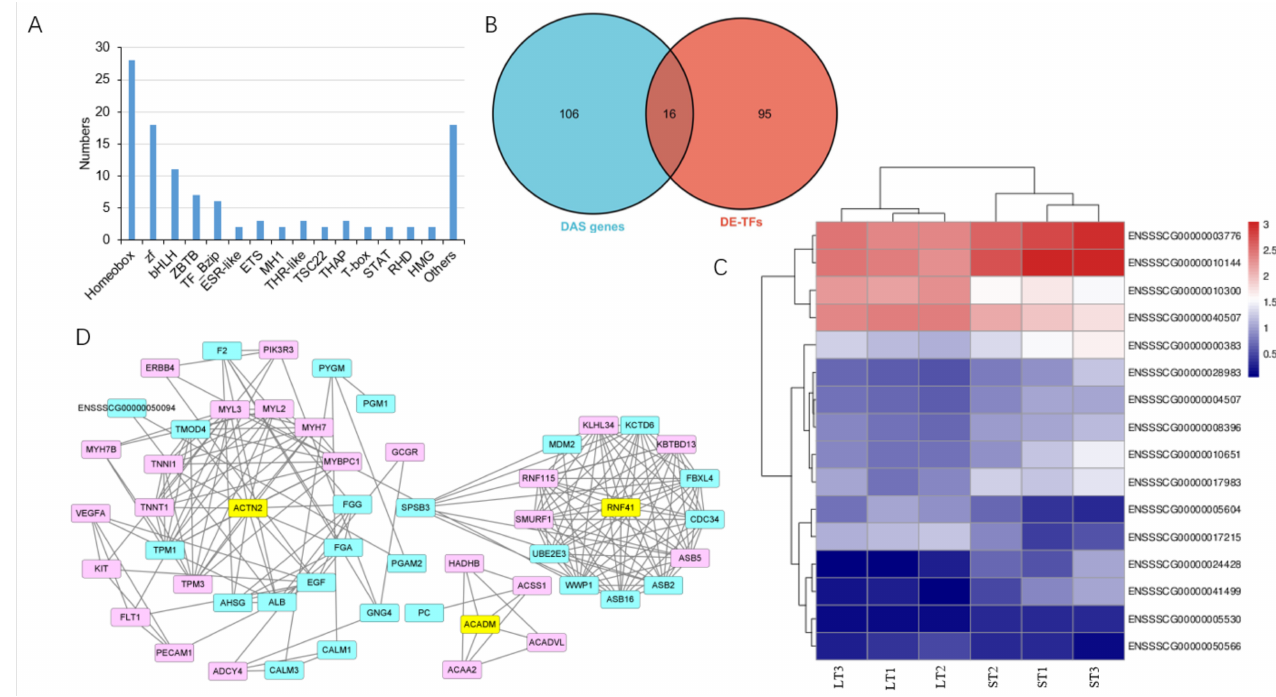
Figure 7. Characterization of differentially expressed transcription factors (DETFs) among differential alternative splicing (DAS) genes. ( A ) family analysis of DETFs; ( B ) Venn diagram of DETFs and DAS genes; ( C ) heatmap of DAS-DETFs; ( D ) protein–protein analysis of DAS-DETFs with differentially expressed genes in semitendinosus compared to longissimus thoracis muscles. Pink, upregulated genes; blue, downregulated genes; yellow,